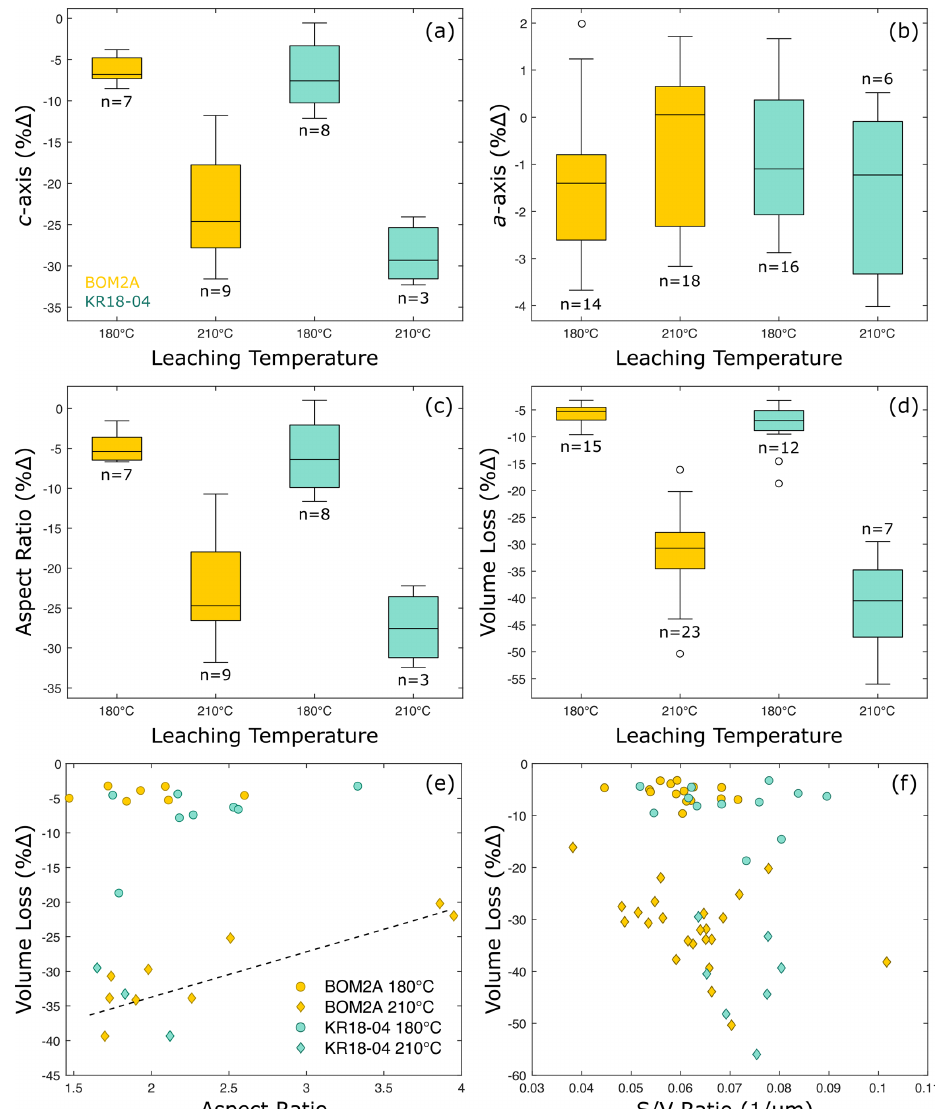
Figure 18. Data plots summarizing crystal morphology, volume, and surface area measurements for KR18-04 and BOM2A. (a) Box plot showing how the length of a grain’s c axis changes during chemical abrasion. In all box plots, the central line represents the dataset’s median; the box extends to the dataset’s 25th and 75th percentiles, the whiskers extend to include the full data range excluding outliers, and circle markers are outliers that exceed the 99% confidence interval. (b) Box plot showing how the length of a grain’s a axis changes during chemical abrasion. (c) Box plot showing how a grain’s aspect ratio ( c/a ) changes during chemical abrasion. (d) Box plot showing estimated volume loss during chemical abrasion. (e) Scatter plot showing the relationship between a grain’s initial aspect ratio and estimated volume loss. (f) Scatter plot showing the relationship between a grain’s initial surface-to-volume ratio and estimated volume